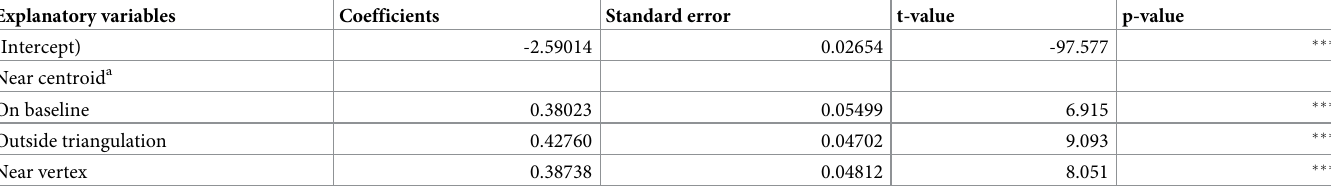
Table 4. Generalised linear mixed model for positional precision. Model coefficients for fixed effects are presented.